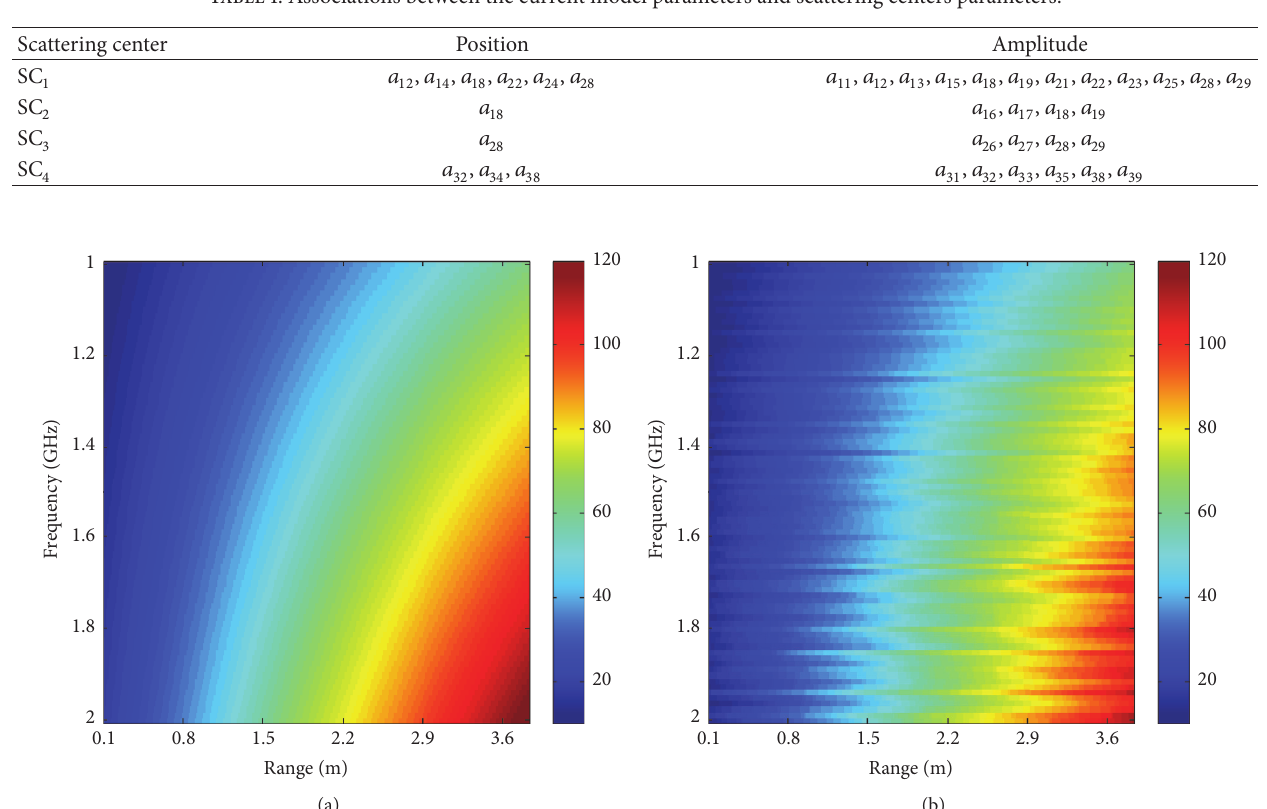
Table 1: Associations between the current model parameters and scattering centers parameters.